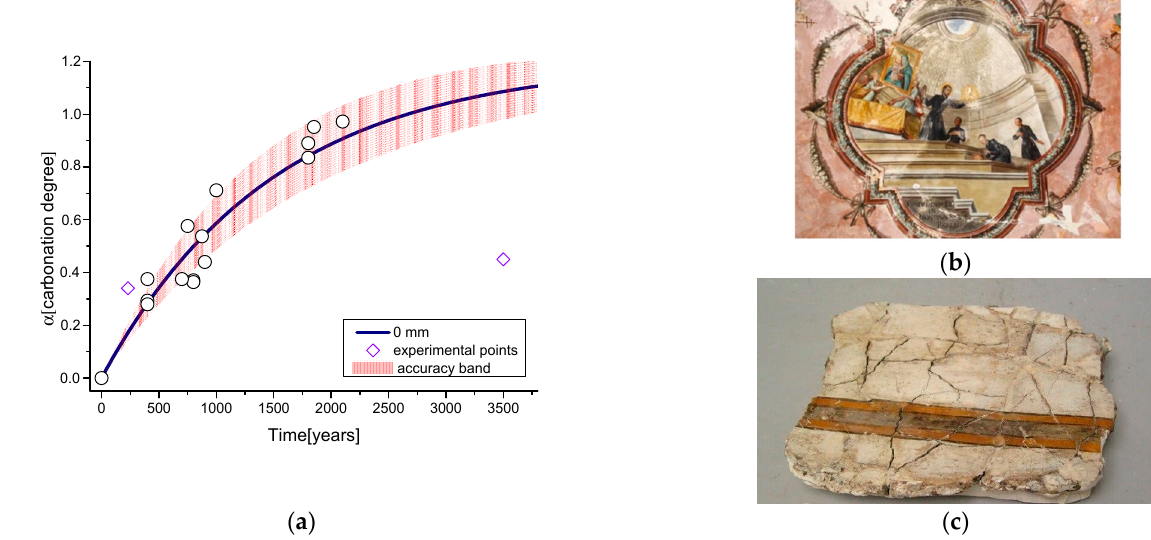
Figure 8. ( a ) Final kinetic model (0 mm) with accuracy band (red); literature points (circles); experimental points (rhombuses); ( b ) San Giuseppe fresco; ( c ) Amorite civilization wall painting fragment from Tell Atchana excavation (ca. 3500 years old).